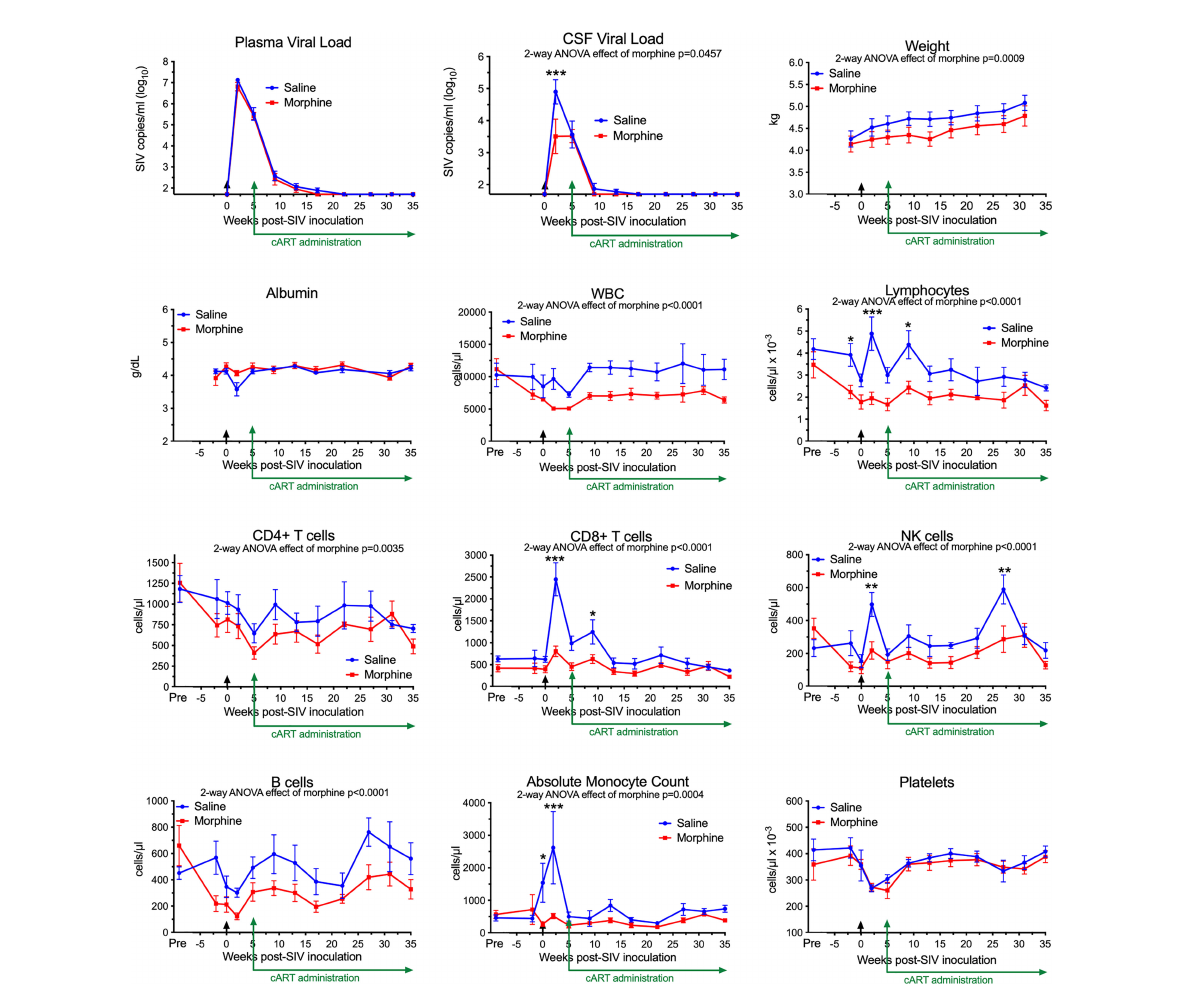
FIGURE 1 Longitudinal Assessments. Viral loads, general health, and blood cell composition in the saline (blue) and morphine (red) groups. The points represent the mean and the error bars the standard error of the mean. Viral inoculation is denoted by black arrow at week 0; cART was begun at week 5 and continued throughout the rest of the experiment. Bio fl uid viral loads were previously reported (57). The weight and albumin data begin at week -2, when the morphine group animals were on stable maintenance doses of morphine. The blood cell composition includes a pre-morphine value (and the equivalent time in the saline group). Statistical testing was done by 2-way ANOVA and the p-value indicated above for signi fi cant differences between the groups. When the ANOVA was signi fi cant, testing on the individual time points was performed using Sidak ’ s multiple comparison test. * = <0.05, ** = < 0.01, *** = <